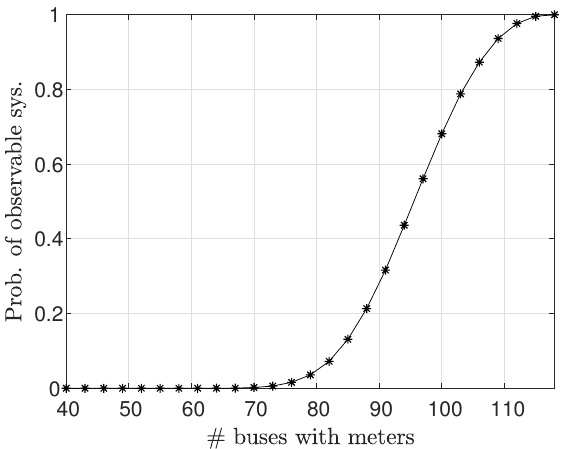
Figure 6. The estimated probability for the IEEE 118-bus system to be observable versus the number of measured